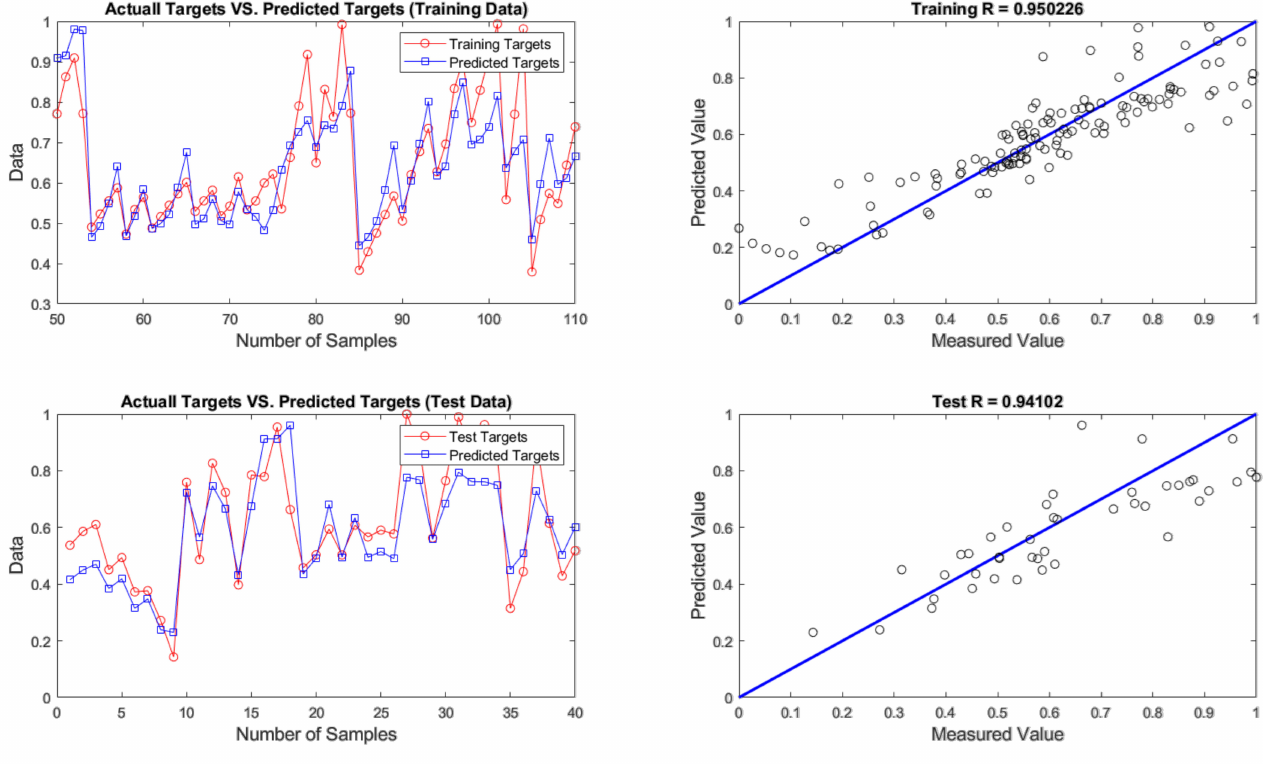
Figure 19. Results of training and testing data for predicting chromium removal using cuckoo